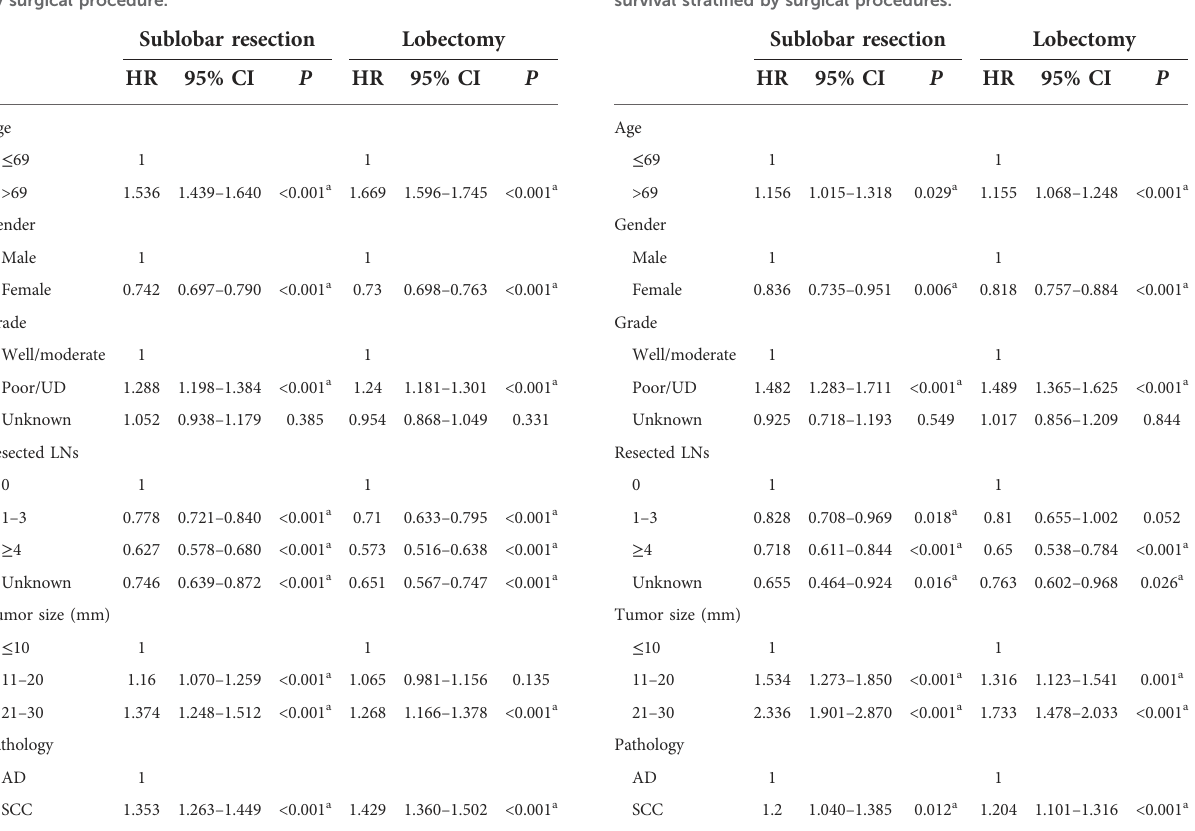
TABLE 7 Multivariate regression analyses for lung cancer – speci fi c survival strati fi ed by surgical procedures.